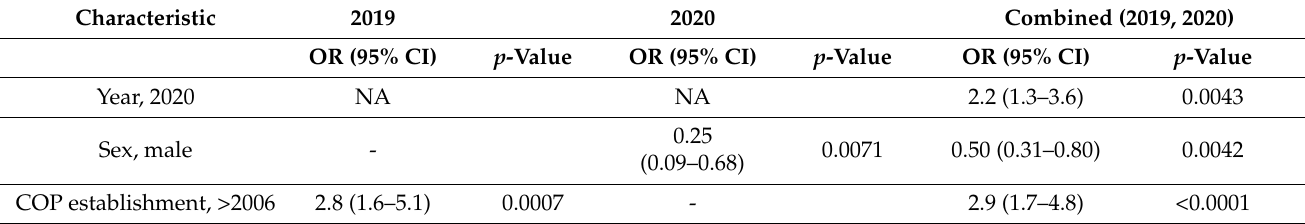
Table 3. Multiple logistic regression